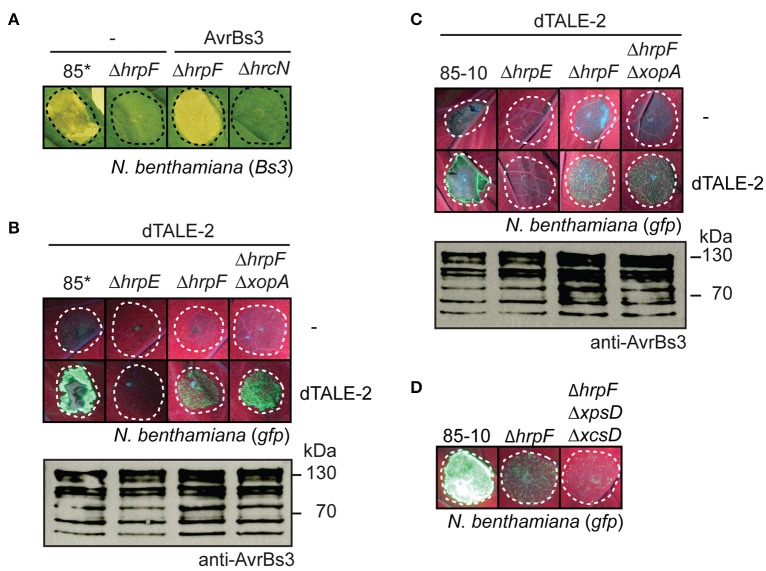
AvrBs3 and dTALE-2 are delivered into N. benthamiana in the absence of a functional translocon. (A) HrpF-independent entry of AvrBs3 into plant cells induces the HR in Bs3 N. benthamiana plants. Strains 85*, 85*ΔhrpF (ΔhrpF) and 85*ΔhrcN (ΔhrcN) without expression construct (−) or ectopically expressing avrBs3 as indicated were infiltrated at a density of 8 × 108 CFU ml−1 into leaves of Bs3-transgenic N. benthamiana plants. Leaves were photographed 8 dpi. Dashed lines indicate the infiltrated areas. (B) Translocon-independent delivery of dTALE-2 into gfp-transgenic N. benthamiana plants. Strains 85*, 85*ΔhrpE (ΔhrpE), 85*ΔhrpF (ΔhrpF), and 85*ΔhrpFΔxopA (ΔhrpFΔxopA) without expression construct (−) or ectopically expressing dTALE-2 as indicated were infiltrated at a density of 5 × 108 CFU ml−1 into leaves of gfp-transgenic N. benthamiana plants. Fluorescence of infected leaf areas was photographed 6 dpi. Dashed lines indicate the infiltrated areas. Fluorescence is reduced in plant tissue infiltrated with strain 85* because of the induction of the non-host HR. For the analysis of protein synthesis, equal amounts of cell extracts were analyzed by immunoblotting using AvrBs3-specific antibodies. (C) Analysis of dTALE-2 in derivatives of strain 85-10. Strains 85-10, 85-10ΔhrpE (ΔhrpE), 85-10ΔhrpF (ΔhrpF) and 85-10ΔhrpFΔxopA (ΔhrpFΔxopA) without expression construct (−) or ectopically expressing dTALE-2 were infiltrated at a density of 5 × 108 CFU ml−1 into leaves of gfp-transgenic N. benthamiana plants. Fluorescence was photographed 13 dpi. Protein synthesis was analyzed as described in B. (D) HrpF-independent entry of dTALE-2 into plant cells is reduced in the absence of functional T2S systems. Strains 85-10, 85-10ΔhrpF (ΔhrpF) and 85-10ΔhrpFΔxpsDΔxcsD (ΔhrpFΔxpsDΔxcsD), which is deficient in the Xps- and Xcs-T2S systems, ectopically expressing dTALE-2 were infiltrated into leaves of gfp-transgenic N. benthamiana plants. Fluorescence was photographed 10 dpi.